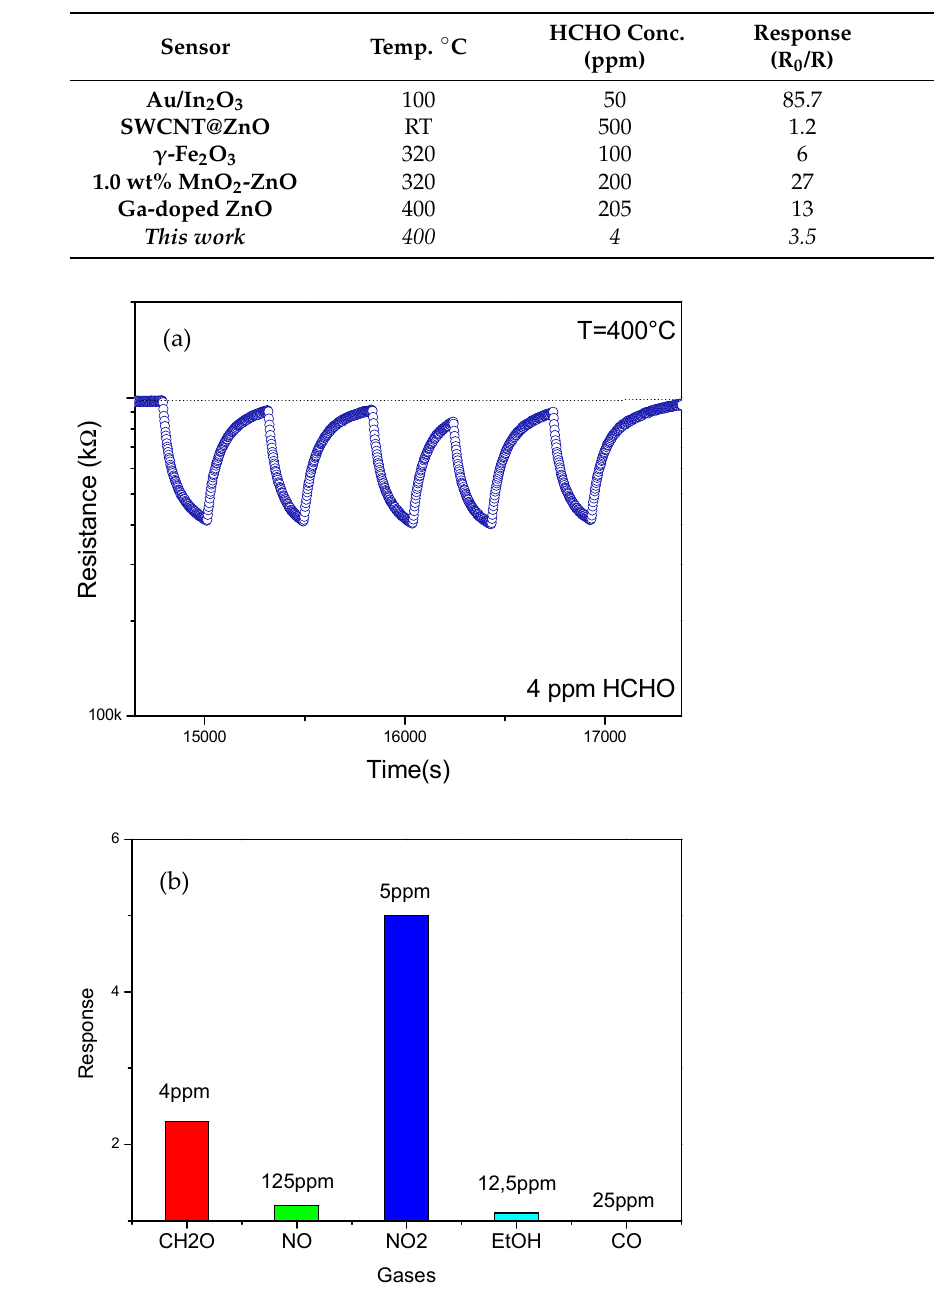
Figure 8 . ( a ) Repeatability and reproducibility tests over time to 4 ppm HCHO at 400 °C; ( b ) Signal trend considering response and recovery time. Selectivity tests of 3Al,3Ca doped ZnO sensor to different gases.